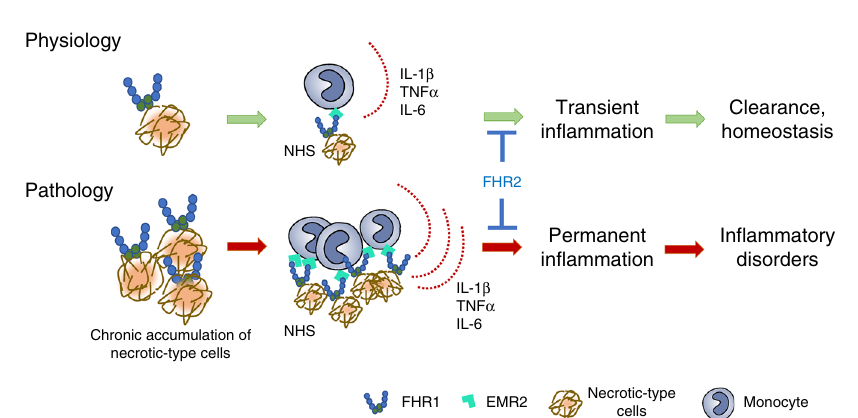
Fig. 7 In vivo functions of FHR1. a In AAV, FHR1 attaches to necrotic cells (arrow), surrounding fresh fi brinoid necrotic lesions in the glomerulus (asterisk) but not in healthy tissue (discontinued arrow) ( n = 79). Glomeruli derived from Δ FHR1/3 AAV patients ( n = 9) lack FHR1 signals. Bars = 20 µ m. b FHR1 (red) signal is found on macrophages and damaged smooth muscle cells in atherosclerotic plaques in human heart valve ( n = 4, bars = 50 µ m) and arteries ( n = 6, bars = 200 µ m) of AS patients. FHR2 staining is located to the intima of arteries. MGTE = Masson Goldner Trichrome Elastica. c EMR2/FHR1 complexes in kidney biopsies of FHR1/3, but not of Δ FHR1/3 AAV patients as shown by PLA assay. DNA is stained with DAPI. Twelve pictures of 3 FHR1/3 and seven pictures of 2 Δ FHR1/3 were analyzed (unpaired two-tailed t -test). Bar = 10 µ m. d Serum IL 1 β and e CRP with FHR1/3 compared to Δ FHR1/3 AAV patients ( d , e unpaired two-tailed t -test with Welch ’ s correction and Kruskal – Wallis Test). f FHR1 concentrations in healthy individuals and AAV patients (unpaired two-tailed t -test, Welch ’ s correction). g Estimated glomerular fi ltration rate (eGFR) decreases (Spearman correlation) and h percentage of relapses of AAV patients increases with growing FHR1 concentrations. i Addition of F(ab) 2 fragments of a FHR1 antibody to NHS reduces monocytic IL- 1 β to a level comparable to in fl ammation in Δ FHR1/3 NHS triggered by necrotic cells. j Natural FHR1 monomers bound to FHR1 SCR1 – 2 and are replaced by FHR2, but k not by dimerization mutant FHR2DM. l FHR1 on necrotic cells in Δ FHR1/3 NHS increases IL-1 β , which is reduced by FHR2 but not m by FHR2DM. Data in a – b show box and whiskers from min to max with mean ± SEM. (Wilcoxon Signed Rank test) and data in i-m represent the mean ± SEM. of three to four independent experiments with different cell donors (unpaired two-tailed t -test). a – m * p ≤ 0.05, ** p ≤ 0.01, *** p ≤ 0.001